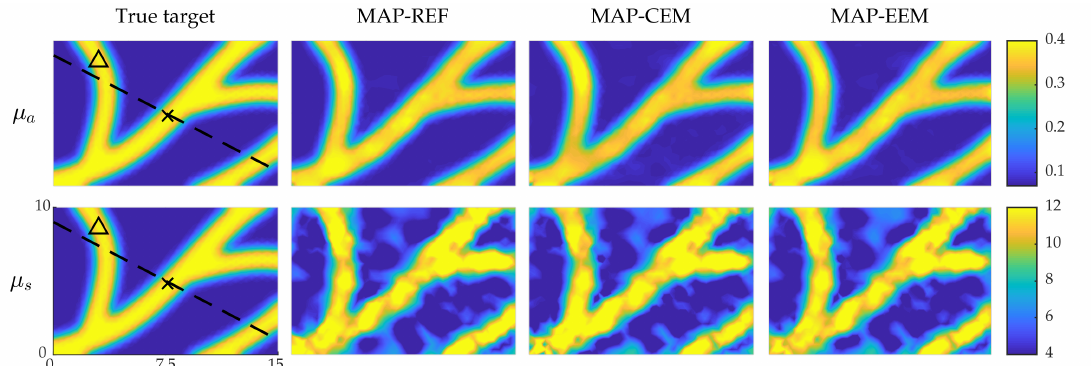
Figure 5. MAP estimates of the simulation with the blood-vessel-mimicking inclusions. True optical parameters ( first column ); MAP-REF estimates ( second column ); MAP-CEM estimates ( third column ) and MAP-EEM estimates ( fourth column ). First row presents the absorption coefficients and second row the scattering coefficients. In the first column images solid line indicates the cross-section in which the credibility intervals are plotted, and × and (cid:52) indicate the points where the marginal densities are plotted. The units of axes are in mm and colorbars in mm − 1 .